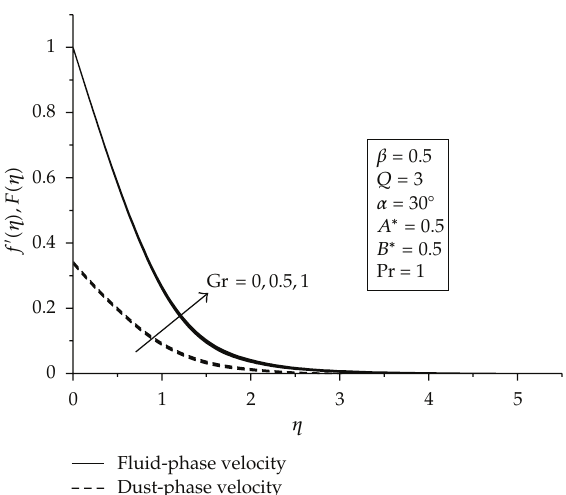
Figure 6: Velocity profile for di ff erent values of local Grashof number.